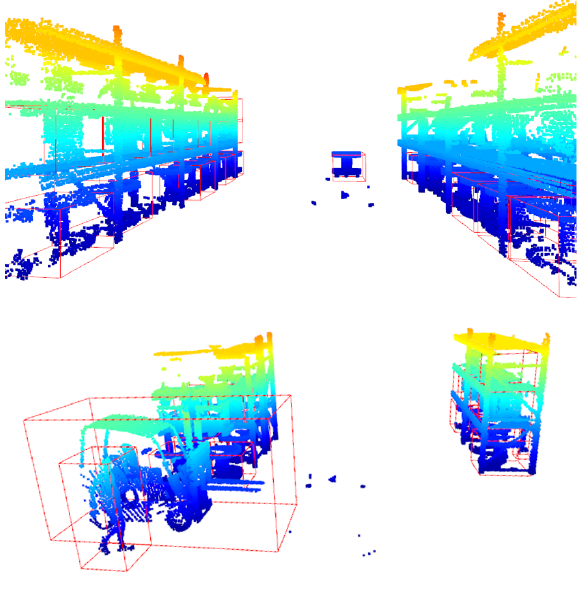
Figure 8. Qualitative results of the proposed object detection framework applied on a sample scene from our synthetic dataset ation algorithm fails to separate the object and therefore, gen- erates improper proposals. Moreover, the provided dataset is partially annotated. Thus, for some classes, such as “Box” and “Bobbin”, the classifier performs a correct detection of the ob- jects (TP) which are not initially annotated in the ground-truth (“Bobbin” instances on the back row of the racks on the right side of Figure 8). Those instances can be added to the back- ground class in the training set and reduce the accuracy of the classifier and detection. The dataset is also not balanced